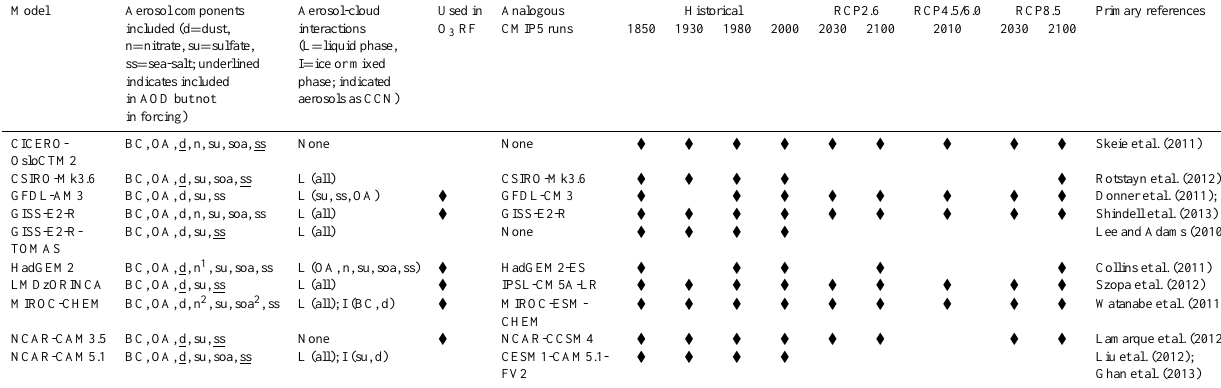
Table 1. Aerosol components included and simulations performed by the ACCMIP models.